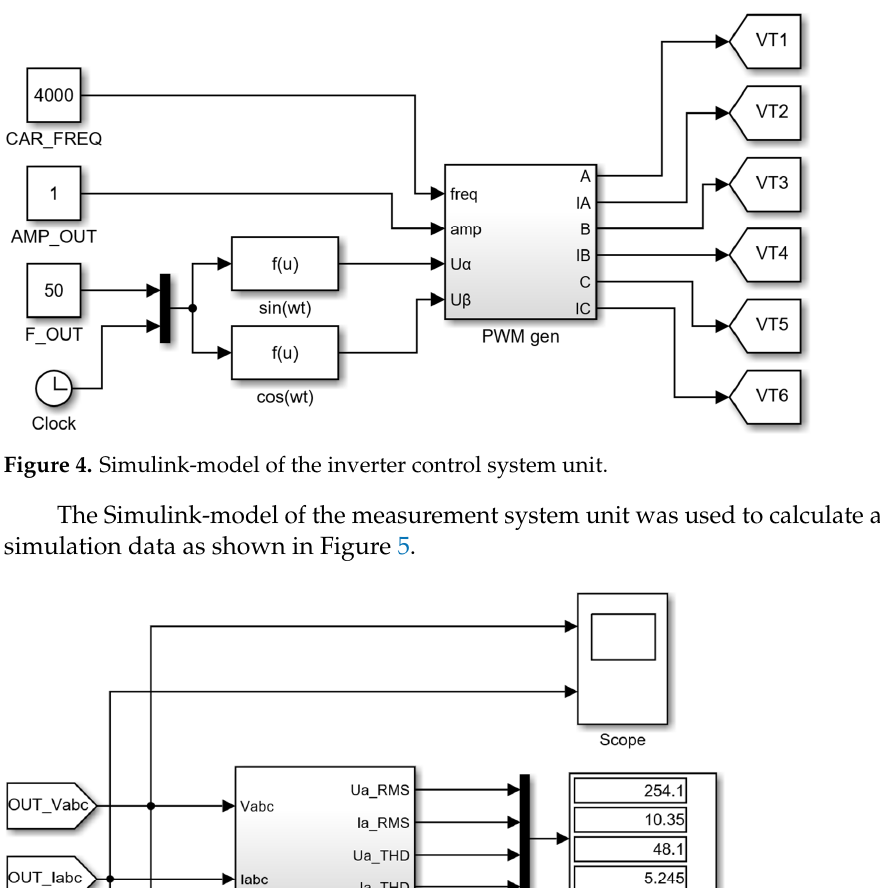
Figure 6. Flowchart to determine the number of transistor switches.